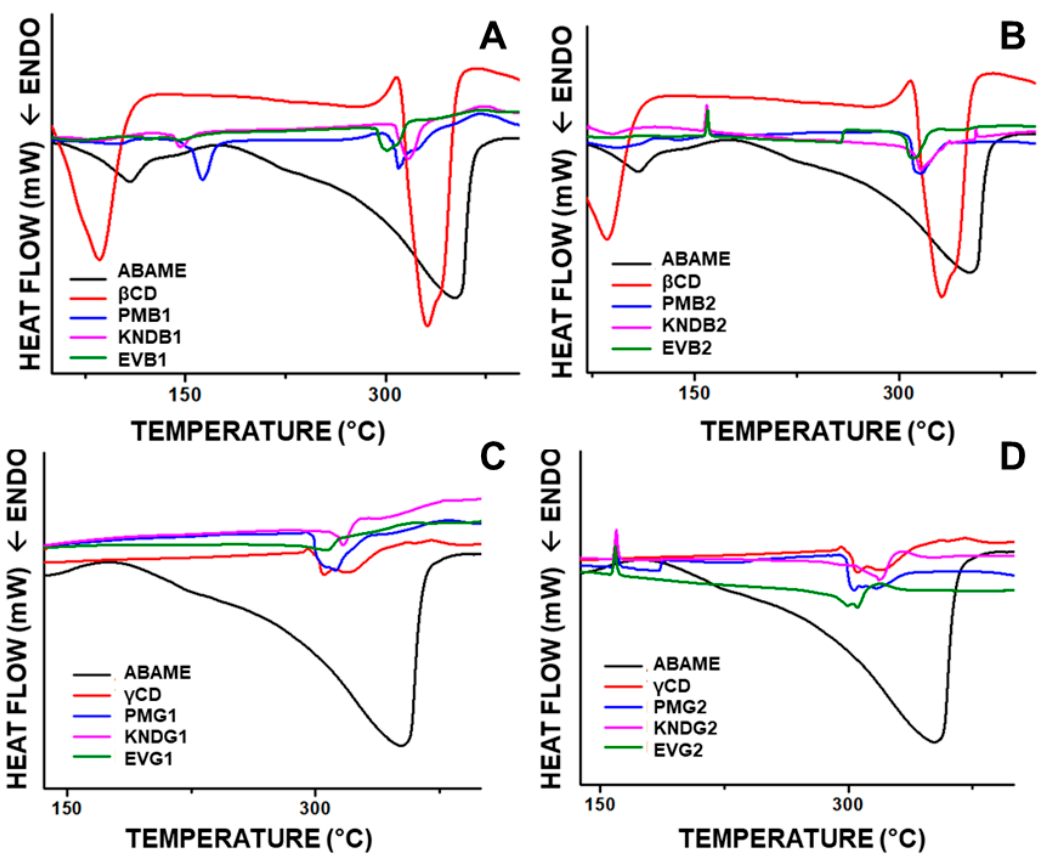
Figure 8. Differential Scanning Calorimetry curves of individual compounds, namely α , β -amyrenone (ABAME), β - cy- clodextrin ( β CD) and γ - cyclodextrin ( γ CD), as well as inclusion complexes (ICs). ICs prepared with ABAME and β CD at 1:1 ( A ) and 2:1 ( B ) molar ratios using physical mixture (PMB1 and PMB2), kneading (KNDB1 and KNDB2), and rotary evaporation (EVB1 and EVB2), respectively. ICs prepared with ABAME and γ CD at 1:1 ( C ) and 2:1 ( D ) molar ratios using physical mixture (PMG1 and PMG2), kneading (KNDG1 and KNDG2), and rotary evaporation (EVG1 and EVG2), respec- tively.